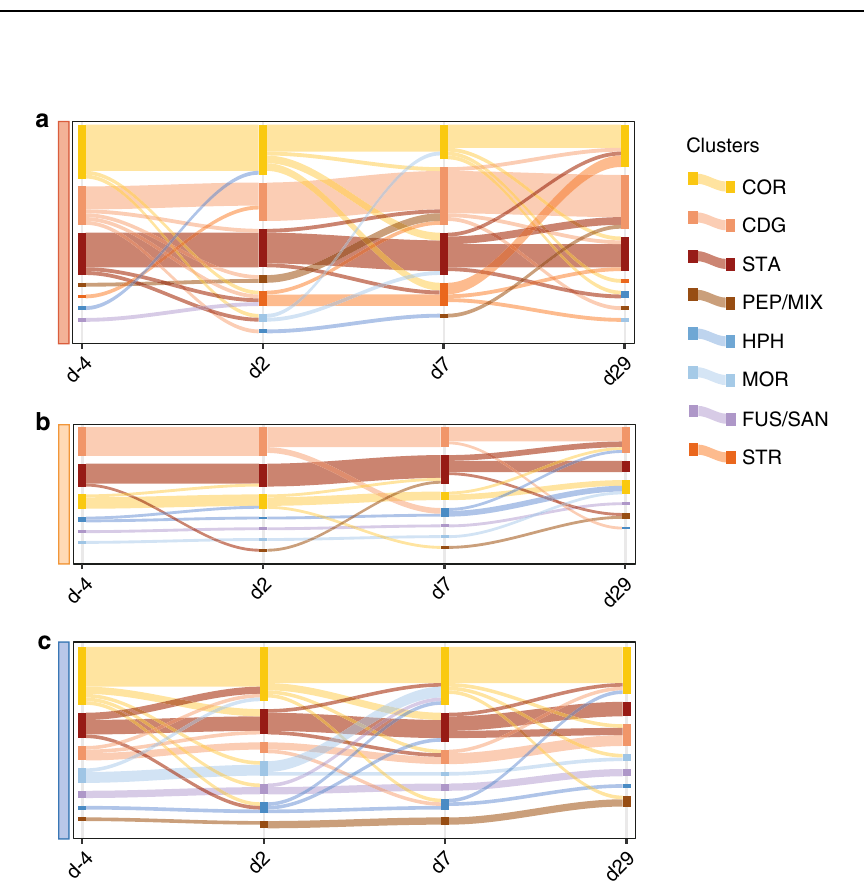
Fig. 3 Dynamics of nasal microbiota pro fi le membership. The number of samples in each cluster at each time point was visualized in alluvial diagrams, which were strati fi ed by pneumococcal carriage 3 outcome. Cluster membership was determined using average linkage hierarchical clustering based on the Bray – Curtis dissimilarity matrix. Clusters were characterized by Staphylococcus ( 2 ; STA); Corynebacterium (3) and Dolosigranulum ( 4 ; CDG); Corynebacterium